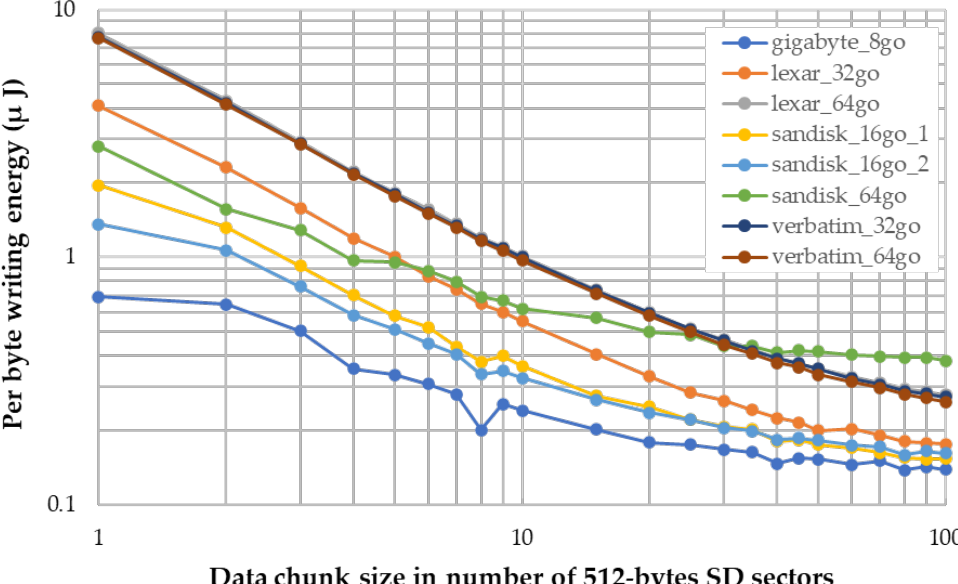
Figure 3. Measure of the “per byte” energy required for SD card writing operation .